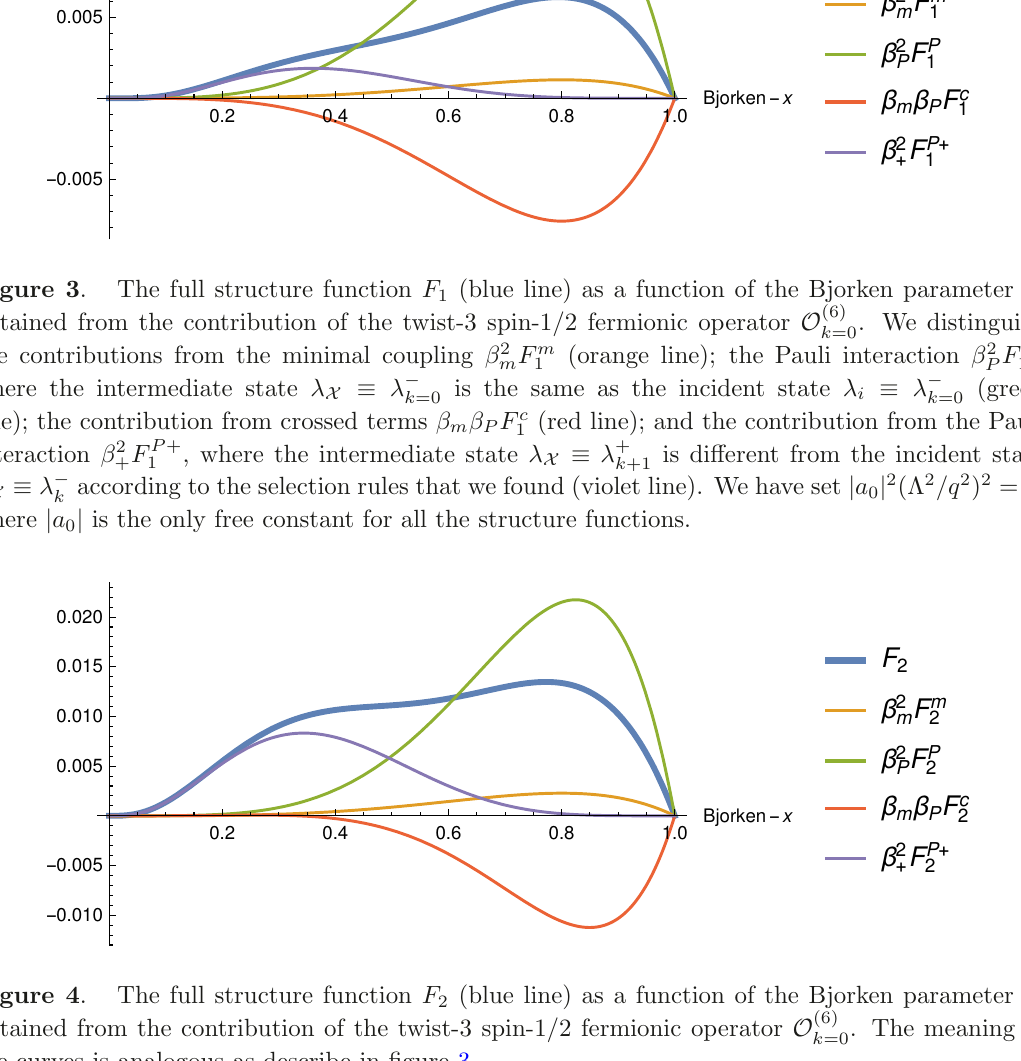
(6) . The meaning of k =0 O